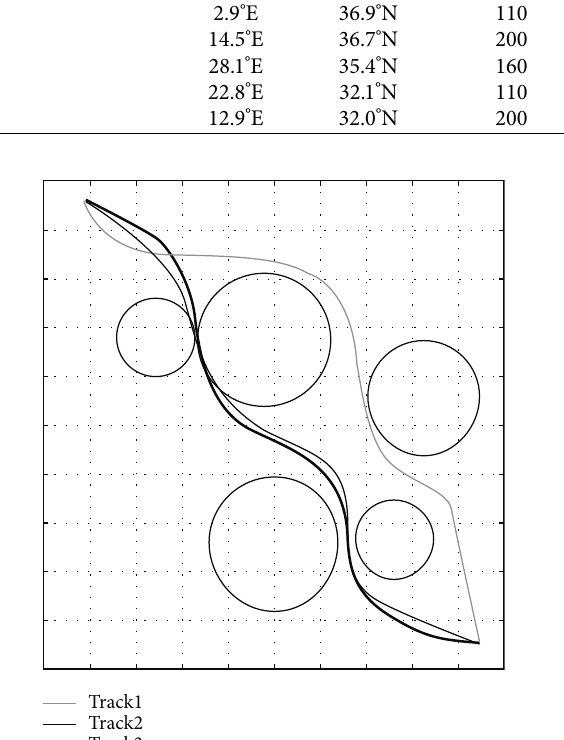
Figure 10: Path 1 covered by volcanic ash.